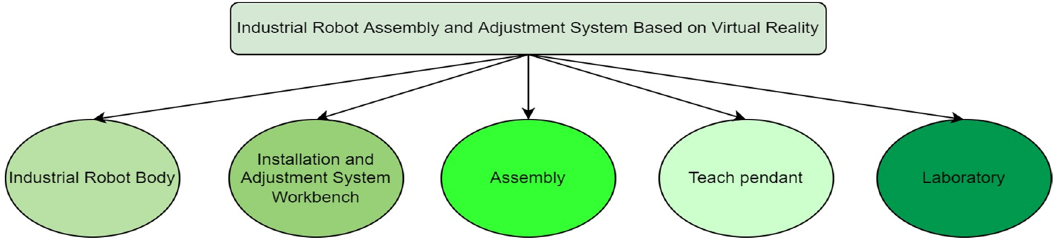
Figure 5: System model